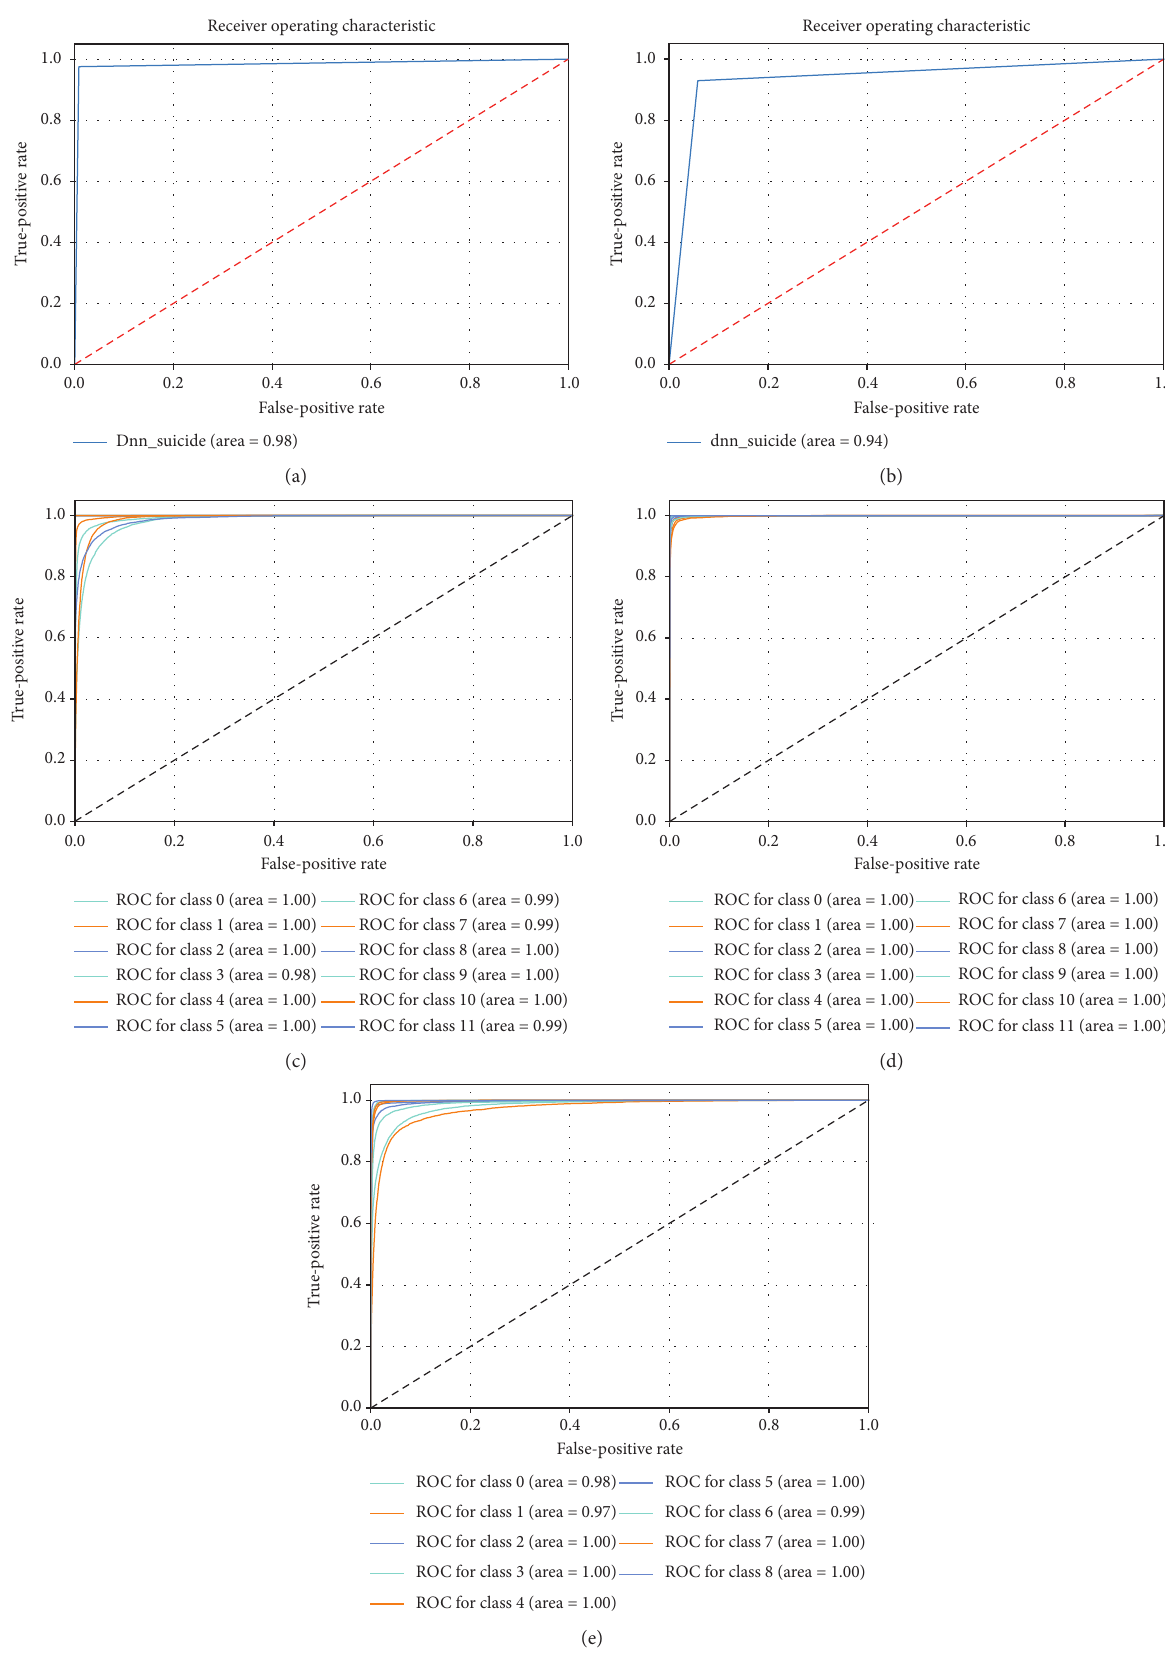
Figure 9: ROCcurvecomputedbydeepneural network inprediction ofsuicide,success,weapontype,region,andattack type.(a)ROCcurve indeep neuralnetwork forsuicideprediction.(b)ROCcurveindeepneuralnetworkforsuccessprediction.(c)ROCcurveindeepneuralnetworkforweapon type prediction. (d) ROC curve in deep neural network for region prediction. (e) ROC curve in deep neural network for attack type